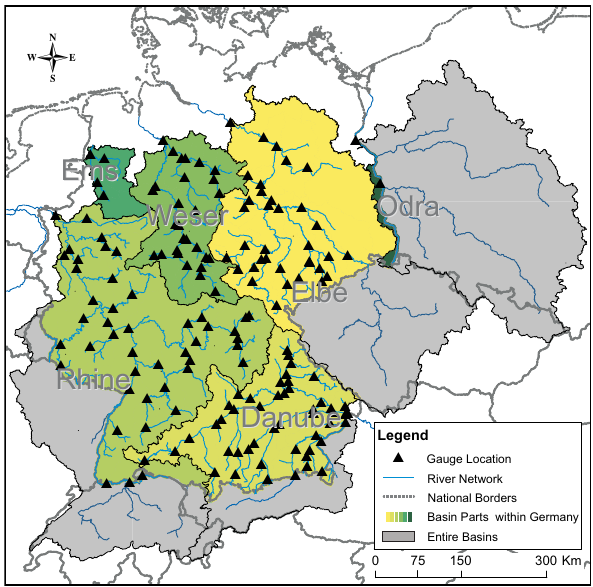
Fig. 1. Basins, locations of gauges, and river network used in the study.